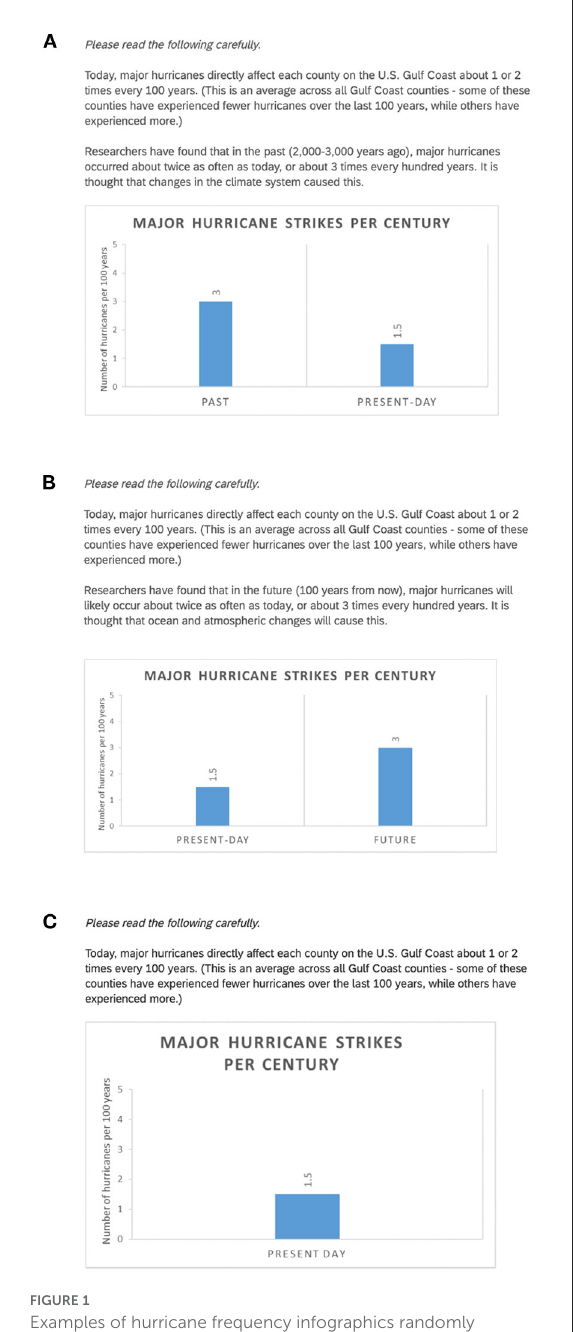
FIGURE1 Examples of hurricane frequency infographics randomly assigned to respondents: (A) Paleo frequency and climate change; (B) future frequency and ocean/atmospheric change; (C)